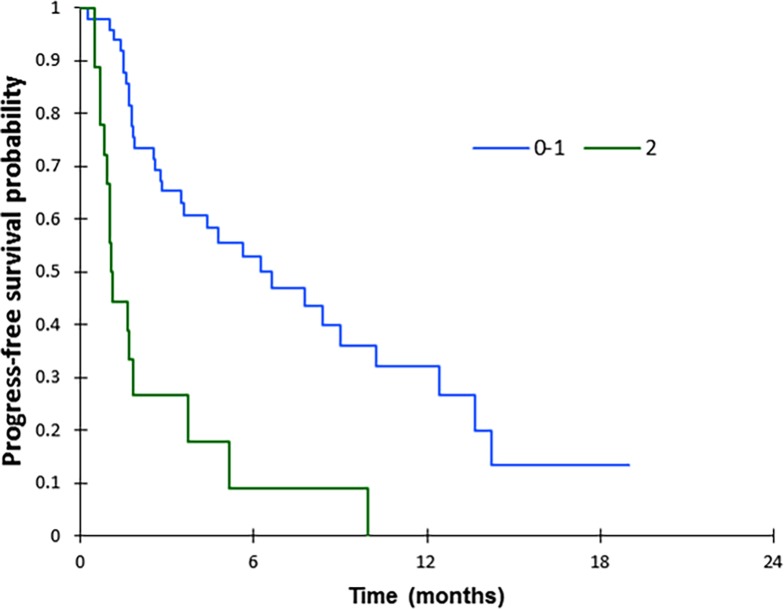
Progression-free survival according to performans status before first cycle of nivolumab.p<0.001 (log-rank test).